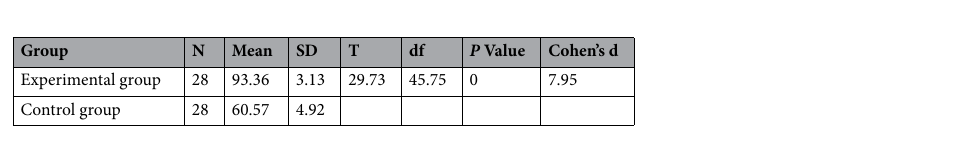
Table 2. T-test of students’ post-test